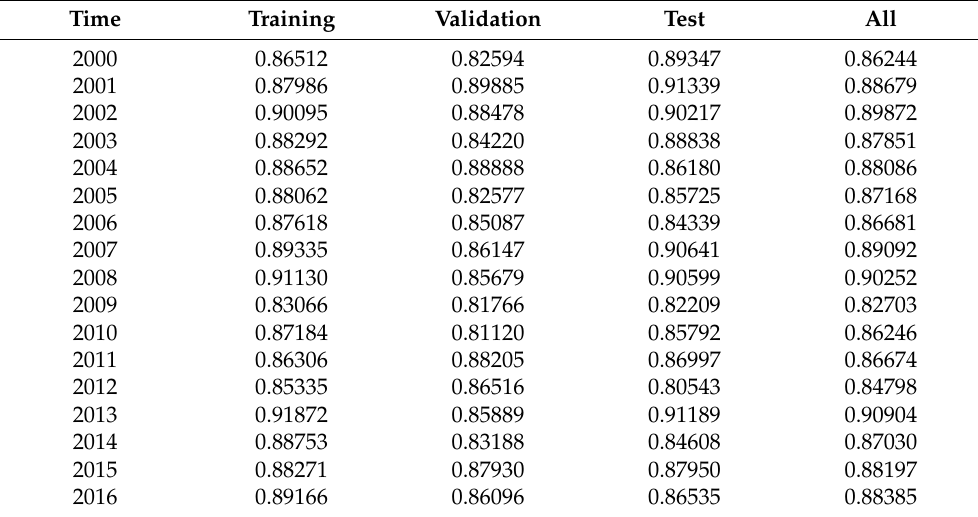
Table 3. Correlation coefficients of the training set, test set, validation set, and BP neural